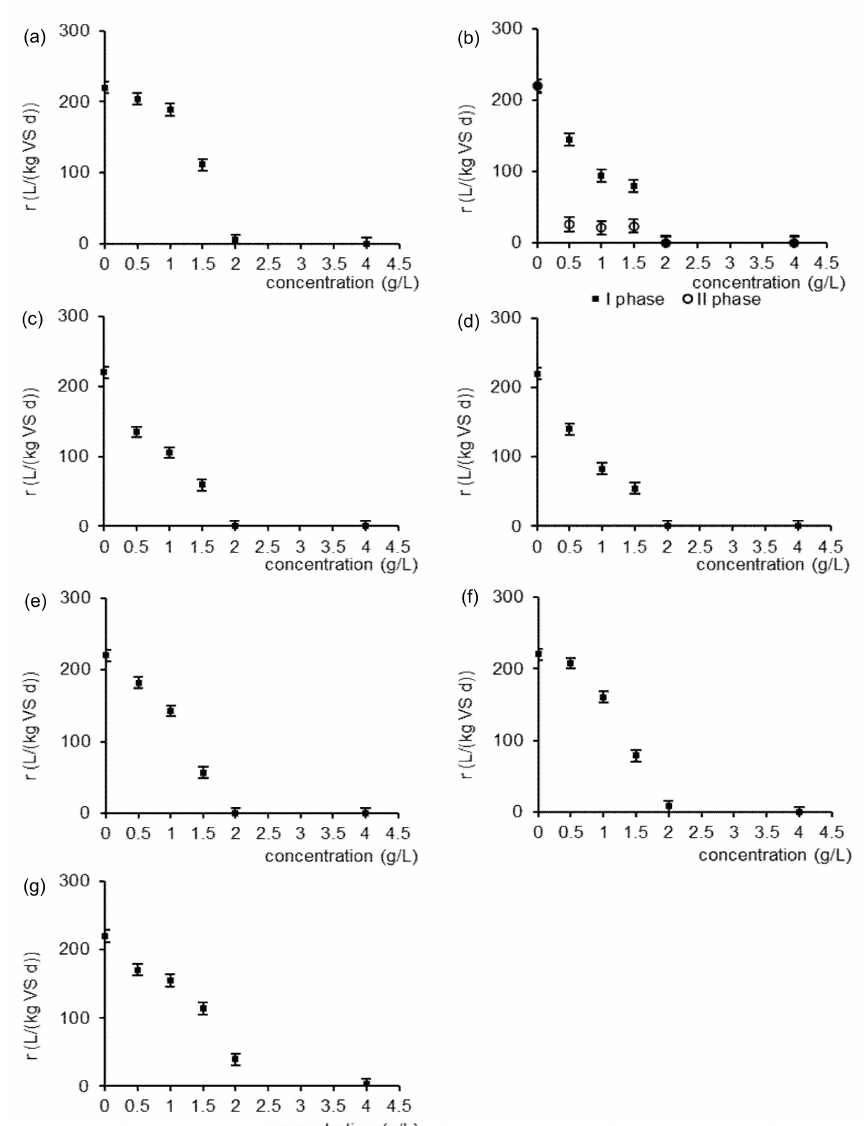
Figure 3. Methane production rates vs. initial concentrations of phenolic acids; ( a ) p-OH benzoic, ( b ) vanillic, ( c ) ferulic, ( d ) syringic, ( e ) p -coumaric, ( f ) sinapic, ( g ) a mixture of